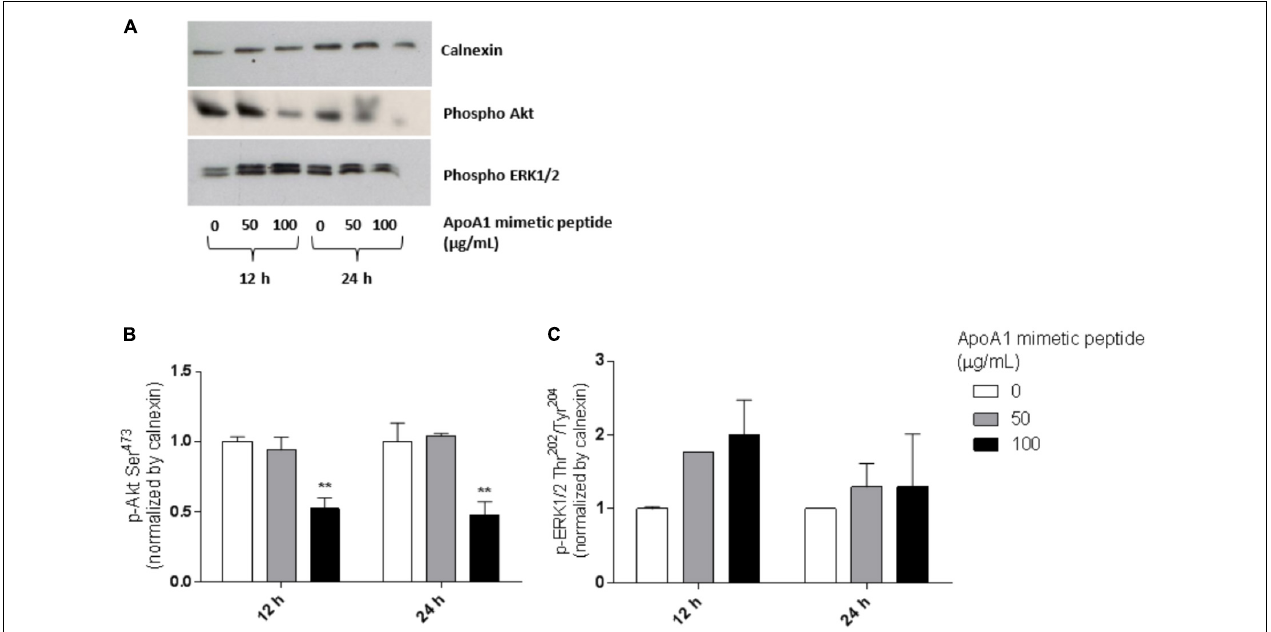
FIGURE 5 | The ApoA1 mimetic peptide strongly suppresses Akt signaling in ovarian cancer cells. After overnight serum starvation, SKOV3 cells were treated with the ApoA1 mimetic peptide (50 or 100 µ g/mL). Untreated SKOV3 cells were used as control. Cell lysates were collected 12 or 24 h after treatment and subjected to western blot analysis. Calnexin was the loading control for these experiments. (A) Western blot for phospho Akt (Ser 473 ) and phospho ERK1/2 (Thr 202 /Tyr 204 ); (B) densitometry for Akt Ser 473 phosphorylation; (C) densitometry for ERK1/2 Thr 202 /Tyr 204 phosphorylation. The ApoA1 mimetic peptide strongly decreased phosphorylation of Akt at Ser 473 after 12 h (two-way ANOVA; p < 0.01) and 24 h ( p < 0.01) of exposure with the highest concentration of peptide (100 µ g/mL). Differences were considered significant if p < 0.05. ∗∗ p <